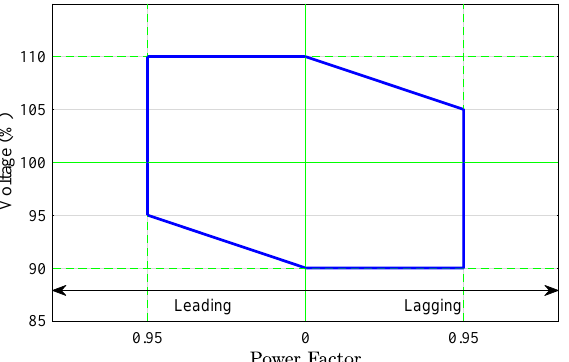
Figure 14. Requirements to meet the power factor in the voltage range at the PCC. Curve valid for plants with 230 kV or 500 kV PAC voltage. The region limited by the line in blue represents the area of power factor regulation for continuous voltage